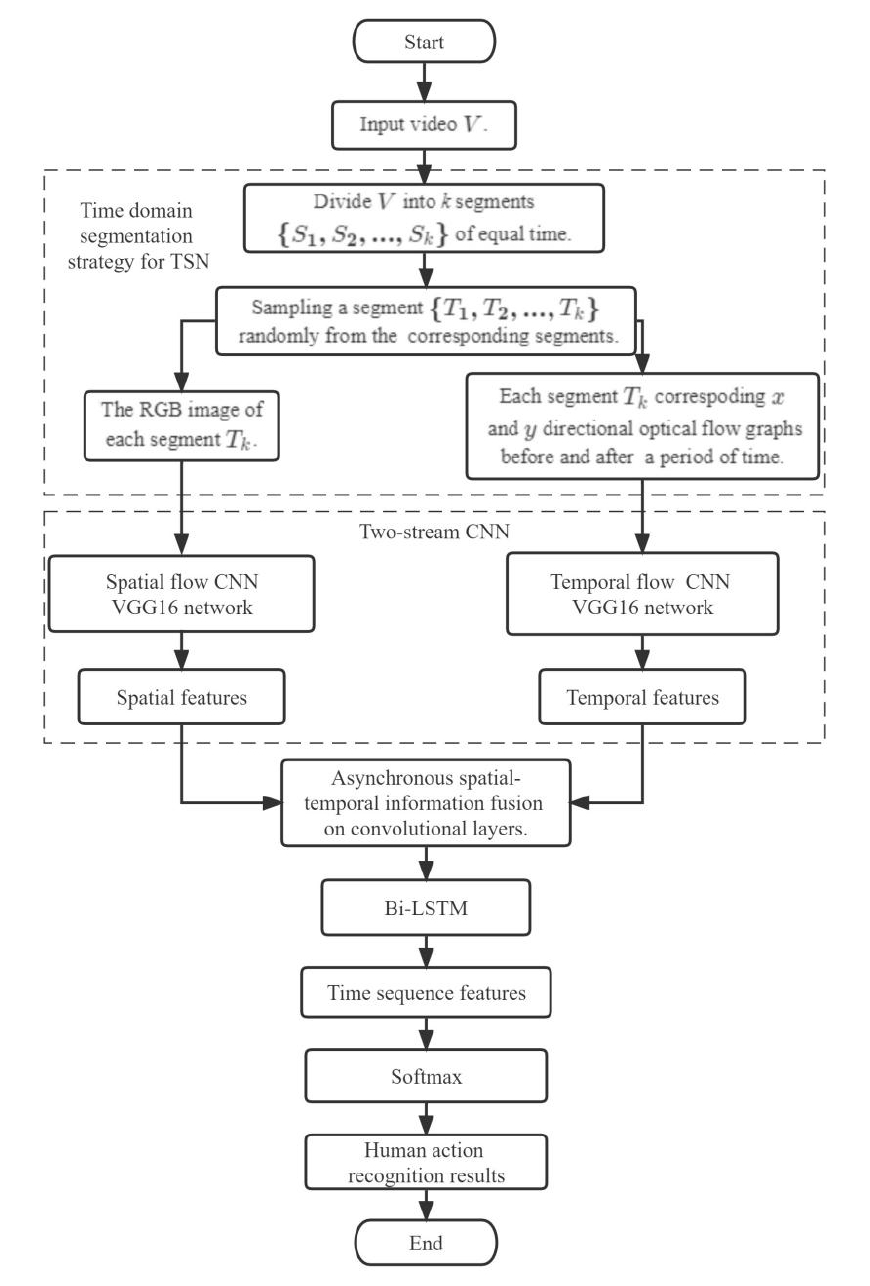
Figure 3. The flowchart of the proposed spatial-temporal fusion network method. Both the spatial and temporal streams are detected by CNN in the two-stream network architecture. The spatial flow CNN focuses on extracting the features of the RGB image sequences, while the temporal CNN processes the optical flow information between the adjacent frames [25]. Spatial and temporal convolutional neural networks adopt the same network structure. The CNN used in this paper is the VGG16 network [23], and the network structure is shown in Figure